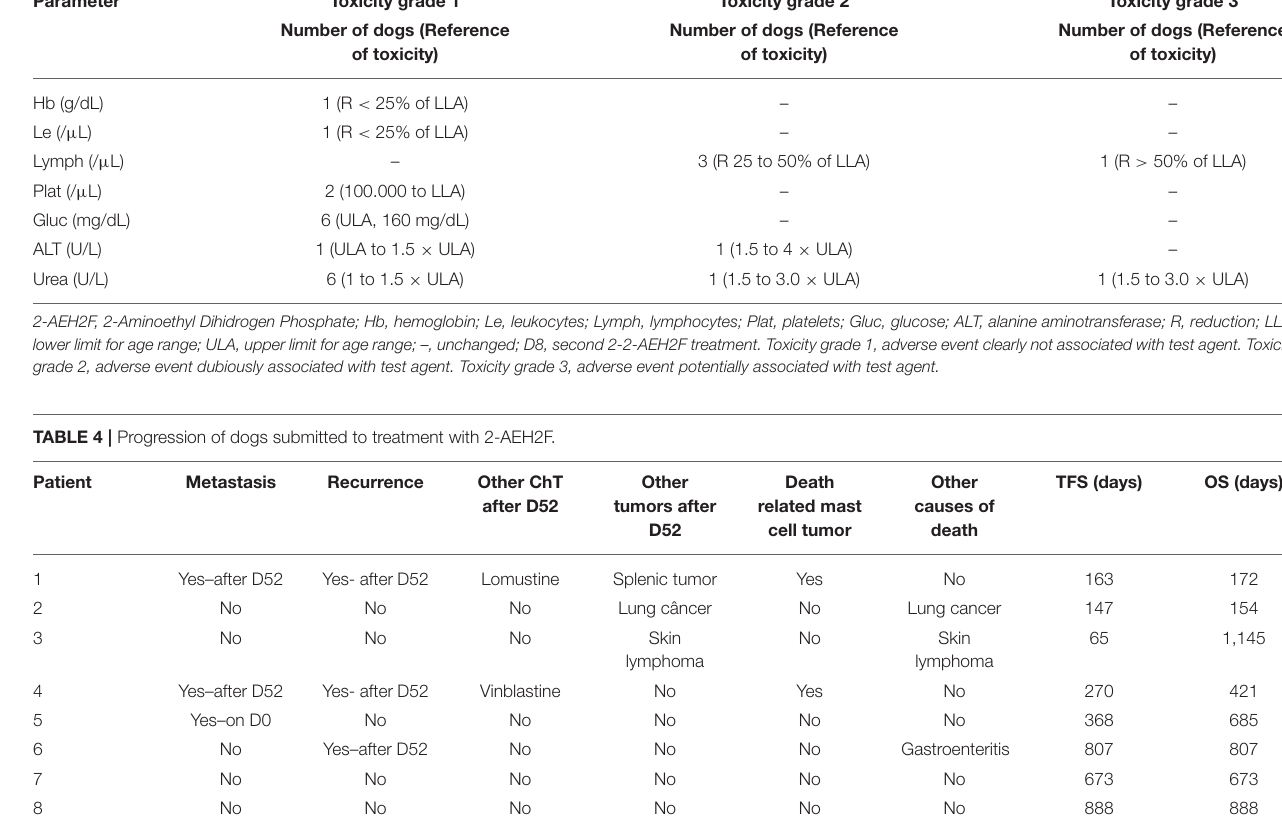
TABLE 3 | Number of dogs showing laboratory changes of toxicity grade following treatment with 2-AEH2F (D8 onwards) (39). Parameter Toxicity grade 1